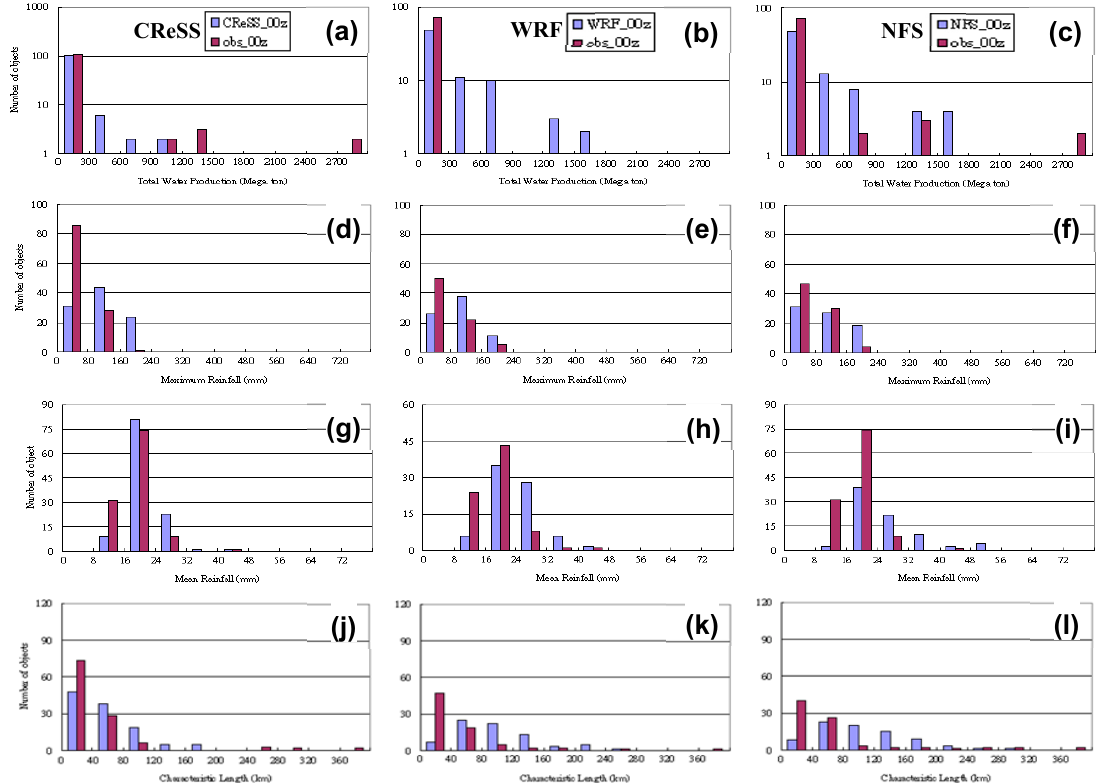
Figure 4. The distribution of number of matched objects as a function of (a-c) total water production (megaton), (d-f) object maximum rainfall (mm), (g-i) object average rainfall (mm), and (j-l) characteristic length (km) between the observation and each of the three model forecasts initialized at 0000 UTC at the range of 12-36 h: CReSS (left column), WRF (central column), and NFS (right column). The number of objects successfully paired with observation is 115, 77, and 81 respectively for CReSS, WRF, and NFS. In panels (a-c) , the logarithmic scale is used in the vertical axis. Note that in panels (a) and (h) , the scale in vertical axis is different from others.